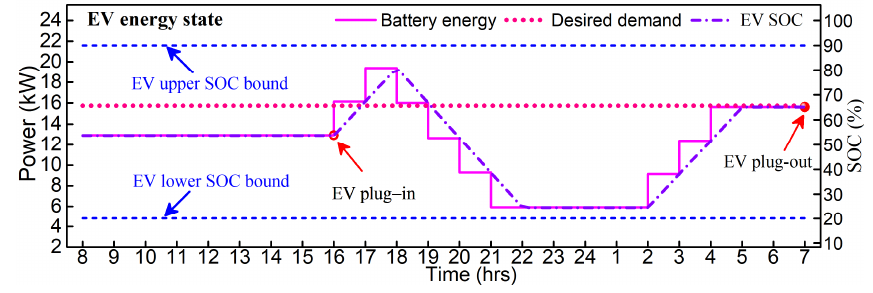
Figure 11. Energy state of the managed EV.